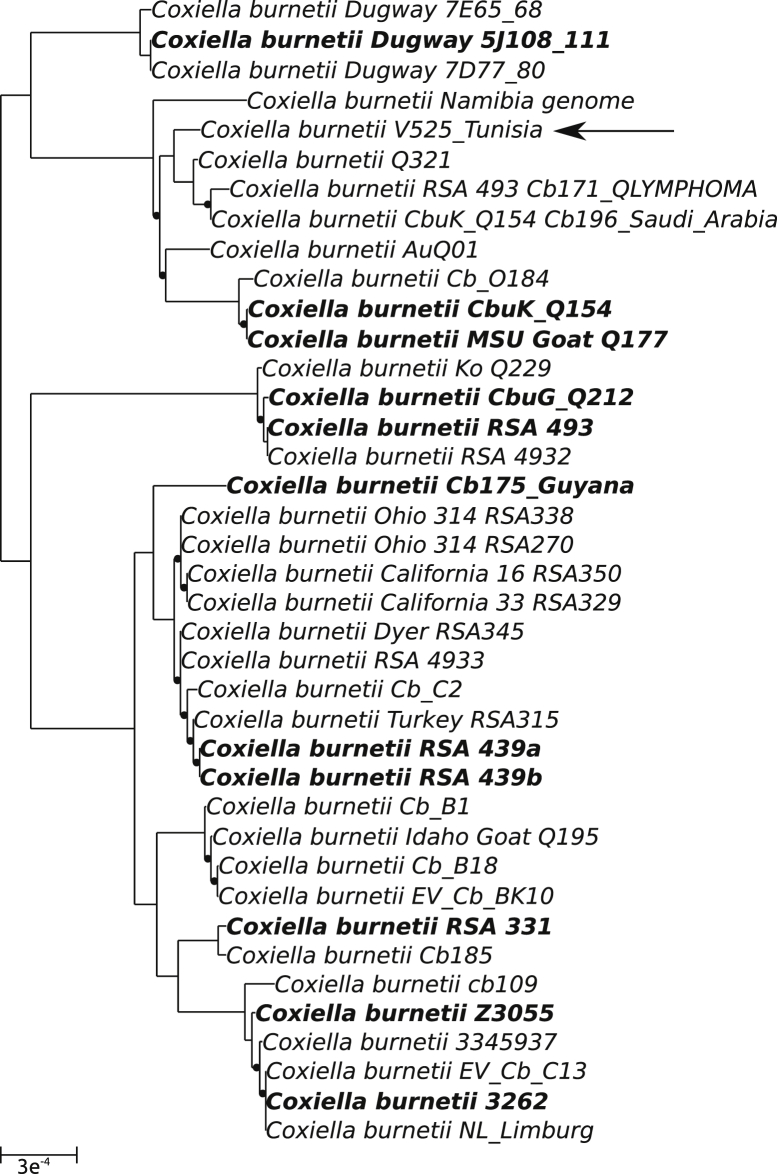
Phylogeny of sequenced Coxiella burnetii genomes based on 915 core single-copy orthologs. Eleven complete reference genomes are labelled in bold. Black dots indicate FastTree support values of <1. Black arrow indicates newly sequenced strain V525_Tunisia. Scale indicates number of substitutions per site.